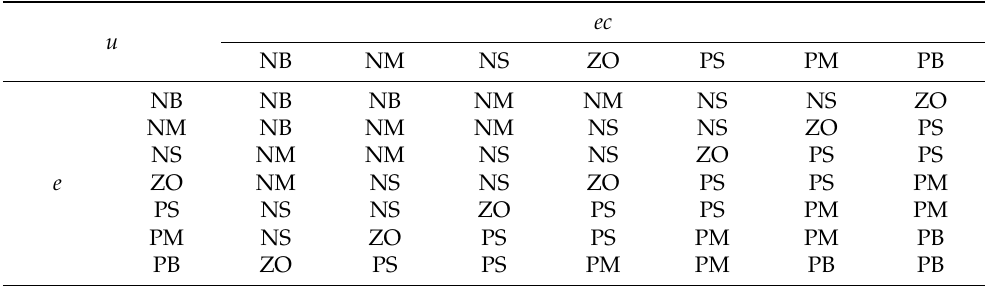
Table 2. Fuzzy control rules